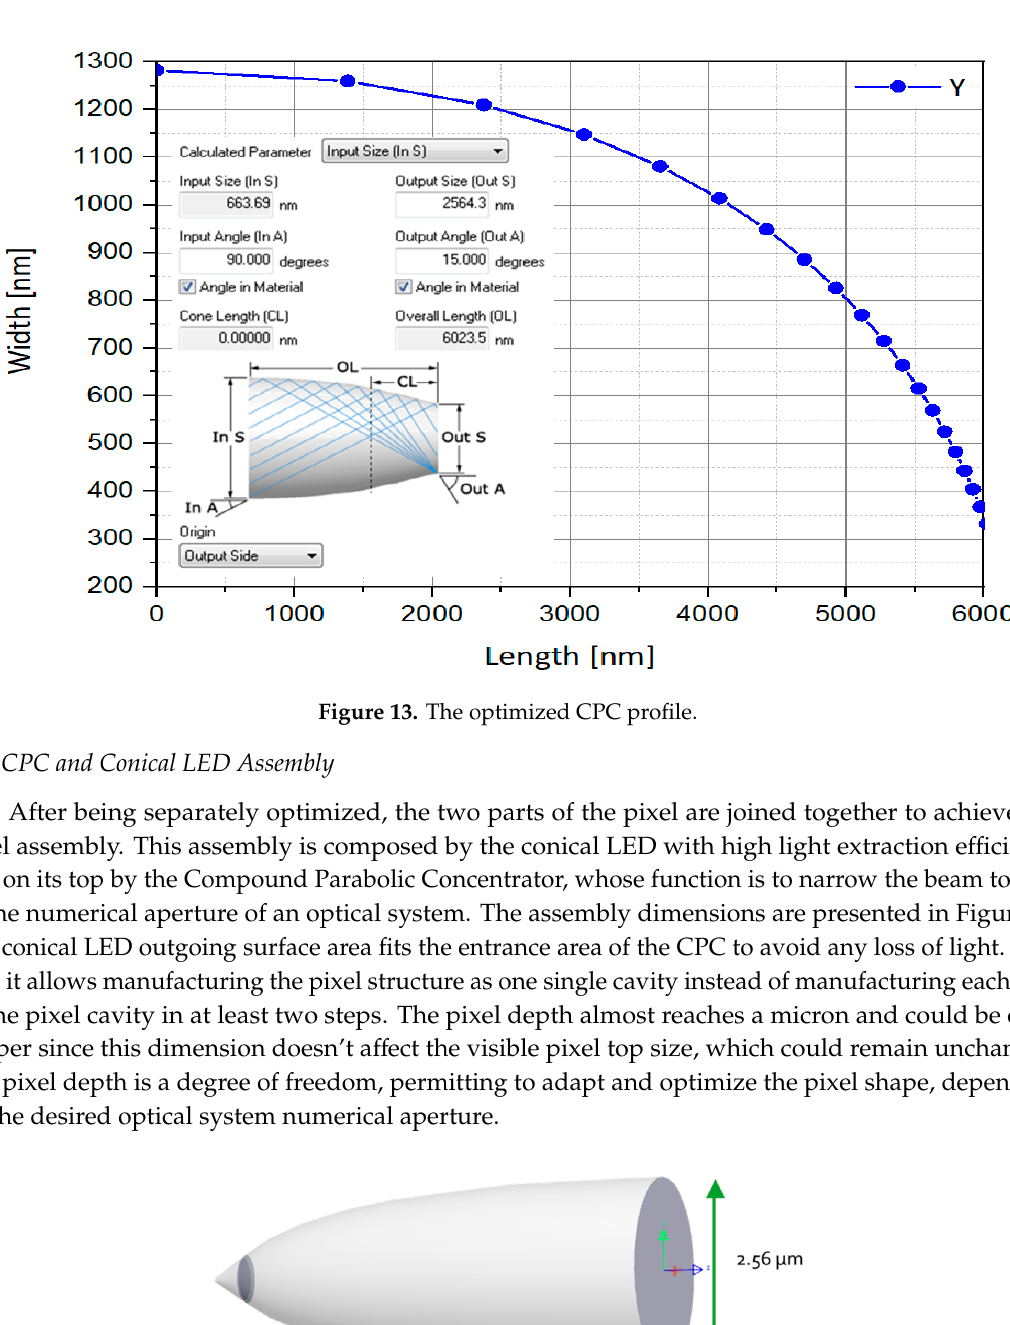
Figure 12. CPC dimensions obtained with LightTools software.